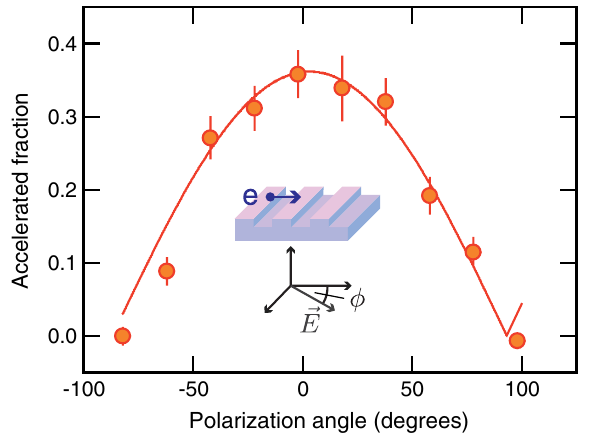
FIG. 11 (color online). Accelerated fraction of electrons as a function of the laser polarization angle ϕ relative to the electrons ’ trajectory. ϕ ¼ 0 ∘ means that the laser polarization is parallel to the electrons ’ momentum, ϕ ¼ 90 ∘ that it is perpendicular to it (see inset). The data agree well with the expected cosine behavior (orange fit curve) and proves that the electrons are directly accelerated by the light